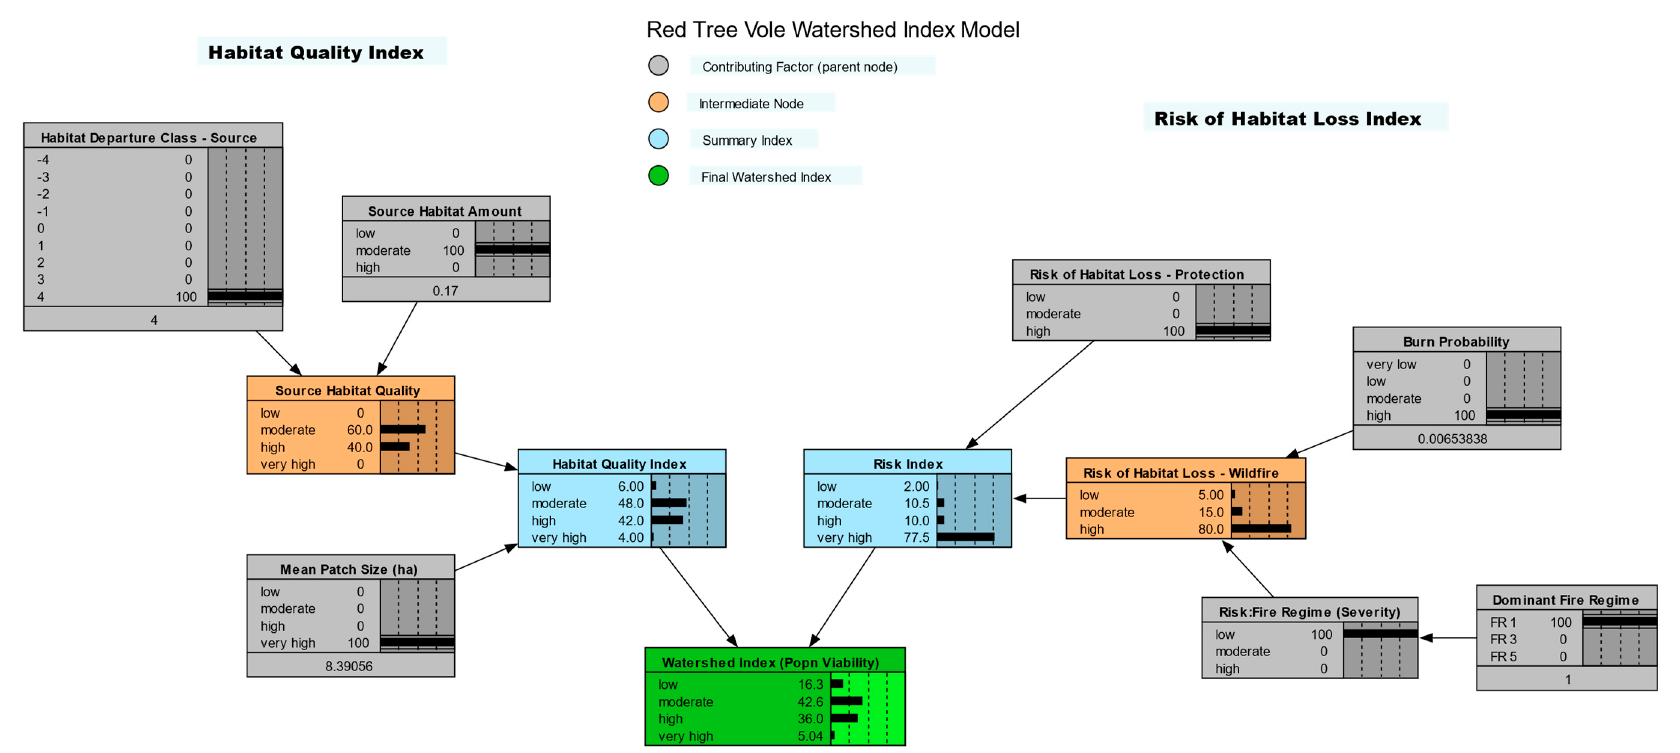
Figure 3. Red tree vole ( Arborimus longicaudus ) watershed index model for the evaluation area in Oregon and California, USA (with sample application).